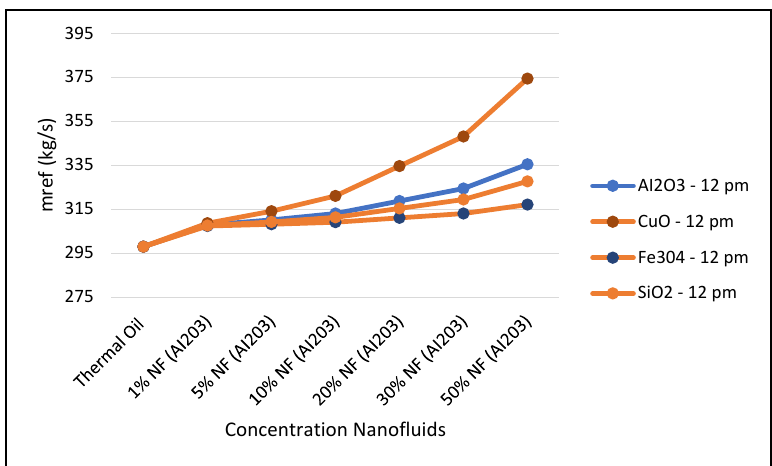
Figure 27. CSP system hybrid ORC refrigerant mass flow rate with different nanofluids at different concentrations.